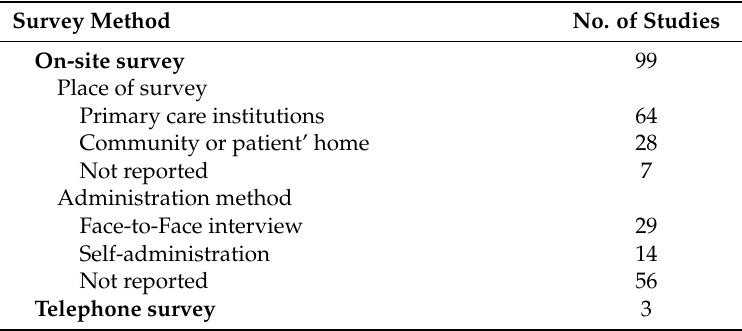
Table 4. Survey administration methods in the 102